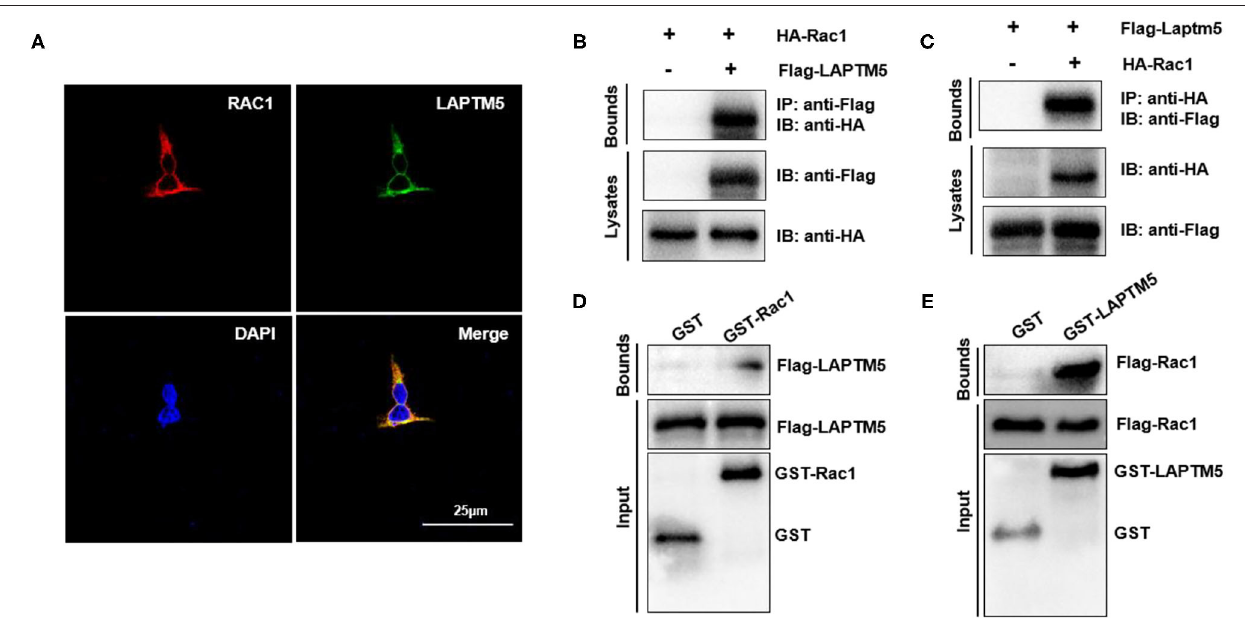
FIGURE 6 | LAPTM5 regulates Rac1 through direct physical interaction. (A) The colocalization of Rac1 and LAPTM5 in 293T cells. The staining of LAPTM5 is green, Rac1 is red and DAPI is blue in representative confocal images. (B,C) The Rac1 and LAPTM5 interaction was detected by immunoprecipitation (IP) assays. (D,E) The direct interaction between Rac1 and LAPTM5 was verified by GST pull-down